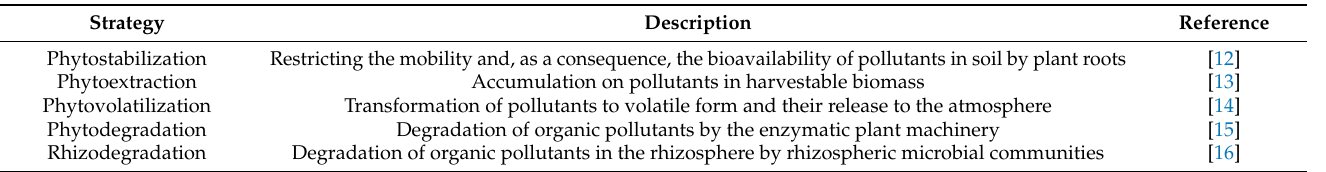
Table 1. Biological strategies in phytoremediation